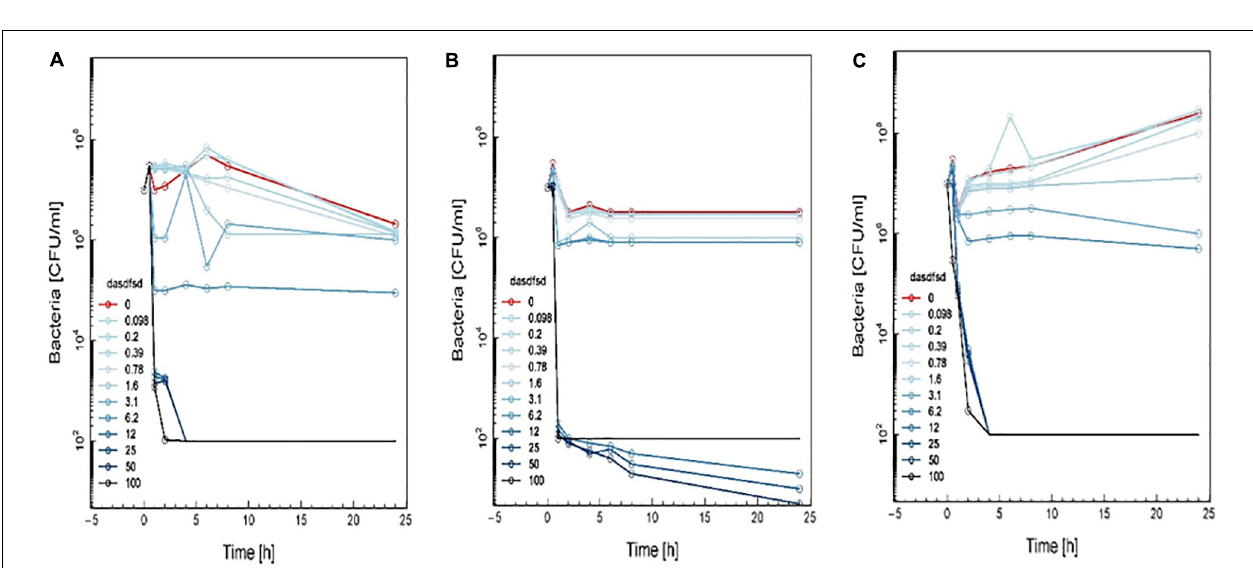
FIGURE 8 | Time-kill curve study of 3 (A) , 13 (B) , and 18 (C) versus MRSA in log-phase at drug exposure. The curve displays the mean CFU for duplicate samples and represents data from two independent experiments. Twelve doubling dilutions are plotted, the highest concentration ( black line ) corresponds to 16 × MIC. Growth in absence of antimicrobial is drawn in red . The compound was added at time point 0 and monitored until 24 h. The limit of detection in the assay was 100 CFU mL − 1 .